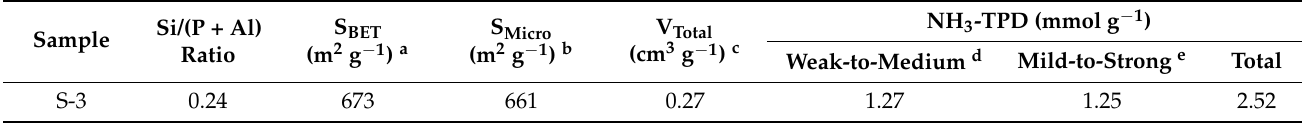
Table 1. The porous and acidity properties of SAPO-34 (S-3) crystallized using [PrPy]OH. Sample